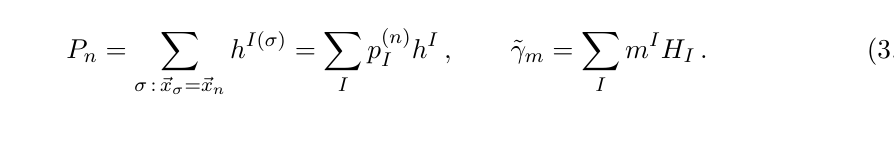
Figure 7 . This (cid:12)gure shows the brane con(cid:12)guration of a single, reducible ’t Hooft defect with ’t Hooft charge P = P p I h I , relative magnetic charge ~ (cid:13) m = P I P ( v I +1 (cid:0) v I ) H I I